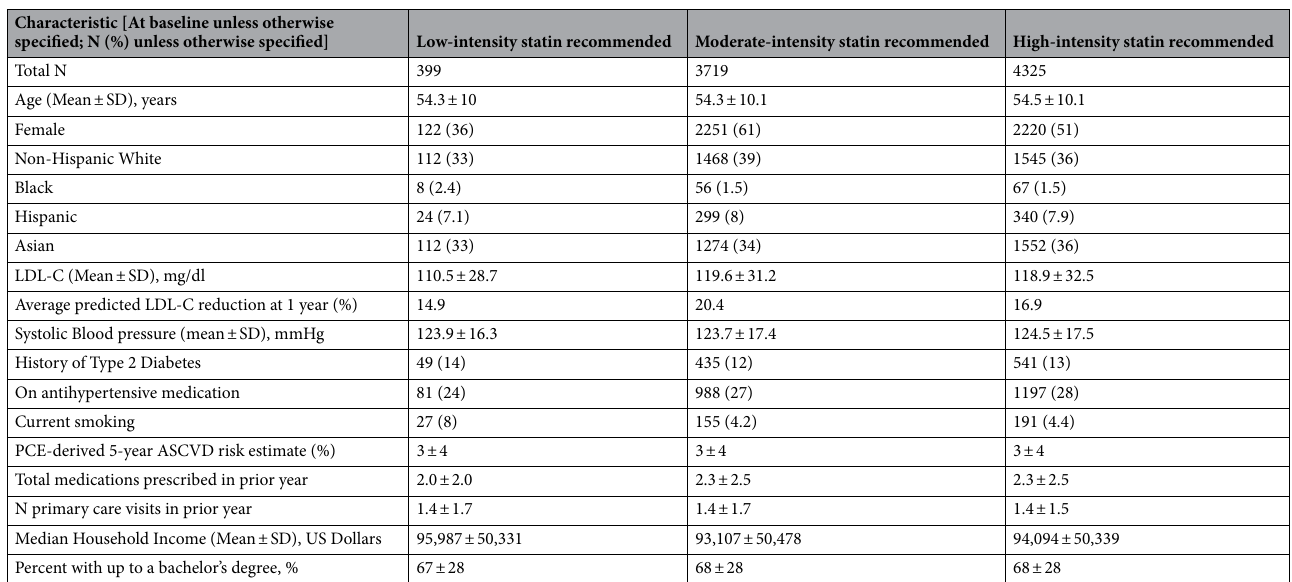
Table 2. Characteristics of test set patients according to recommended statin therapy. ASCVD Atherosclerotic cardiovascular disease, LDL-C Low-density lipoprotein cholesterol, PCE Pooled cohort equations, SD Standard deviation, US United